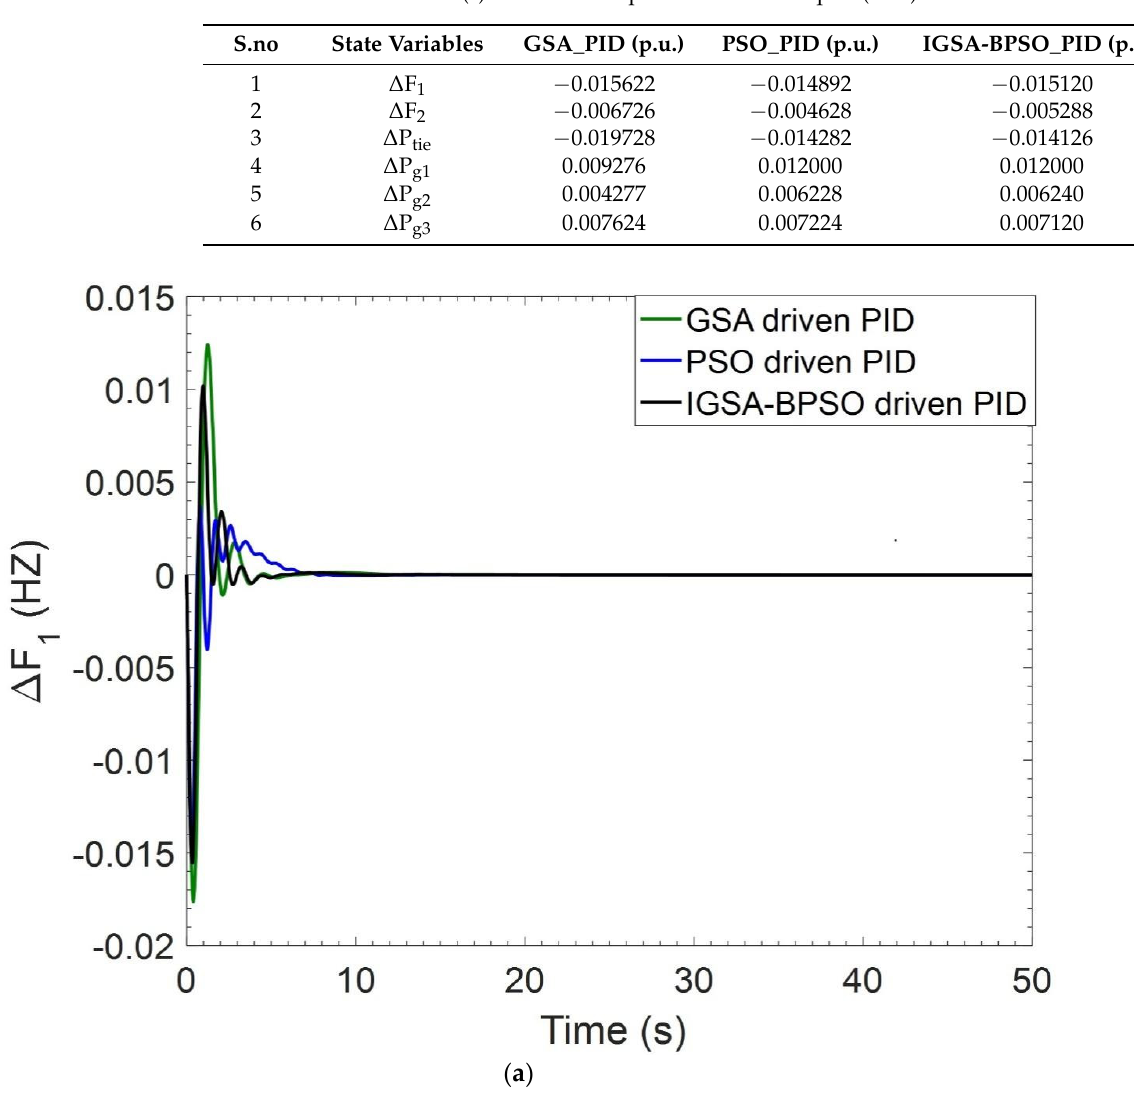
Table 3. Overshoot values(s) for different optimization techniques (O.T.)–PBT.